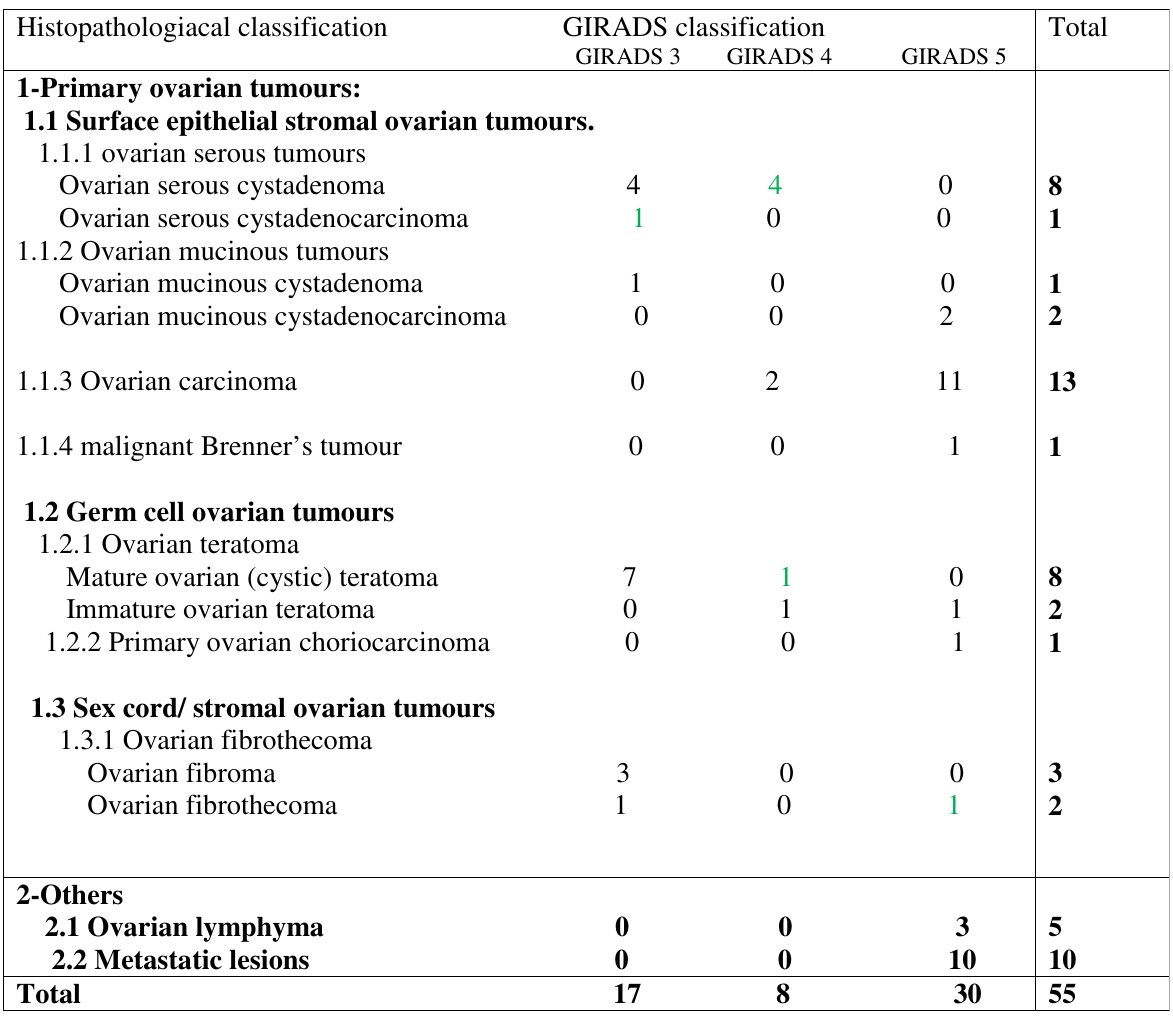
Table 5 Correlation between histopathological classification and GI-RADS reporting system [17, 18]